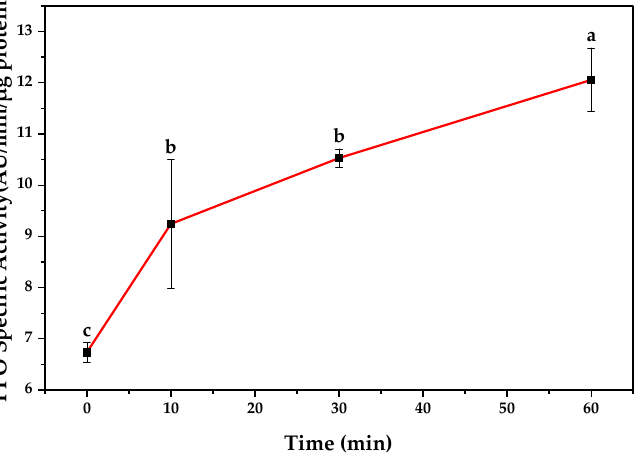
Figure 3. The specific activity of PPO in fresh-cut eggplant slices exposed to room temperature in different times. Results are indicated as mean ± SD ( n = 3). a,b,c: Different small letters indicate a significant difference ( p ≤ 0.05, one-way ANOVA, Tukey’s HSD test).